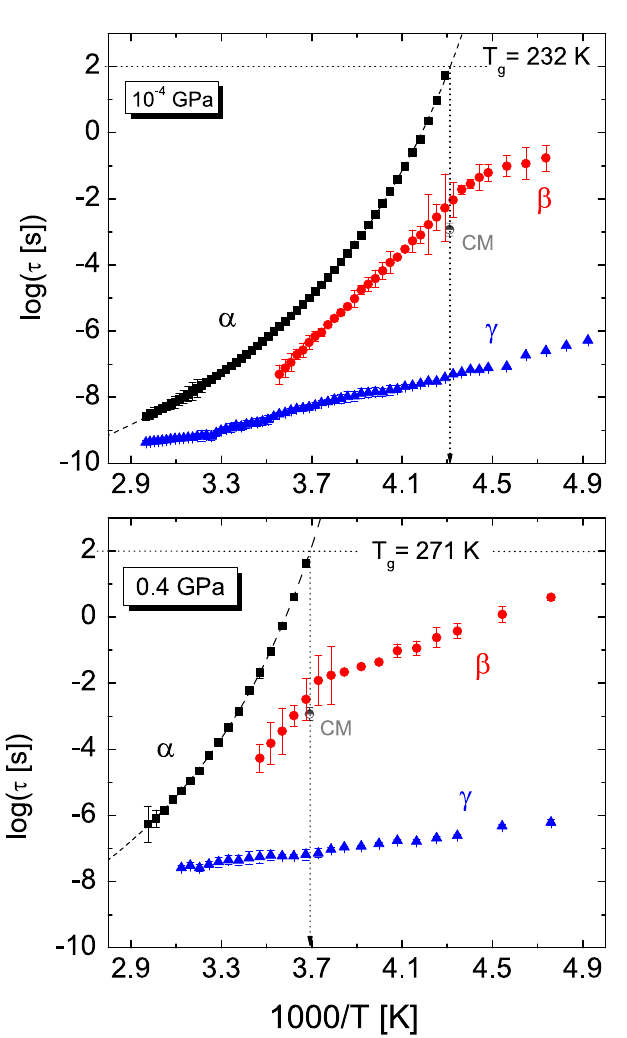
Figure 3. Arrhenius plot of the relaxation times for all three dynamic processes observed in TDZ in isobaric measurements, at ambient pressure (upper panel) and at 0.4 GPa (lower panel). Error bars are smaller than markers except where they are indicated. The grey half-filled circle with error bar corresponds to the precursor relaxation time near T g , calculated according to the Coupling